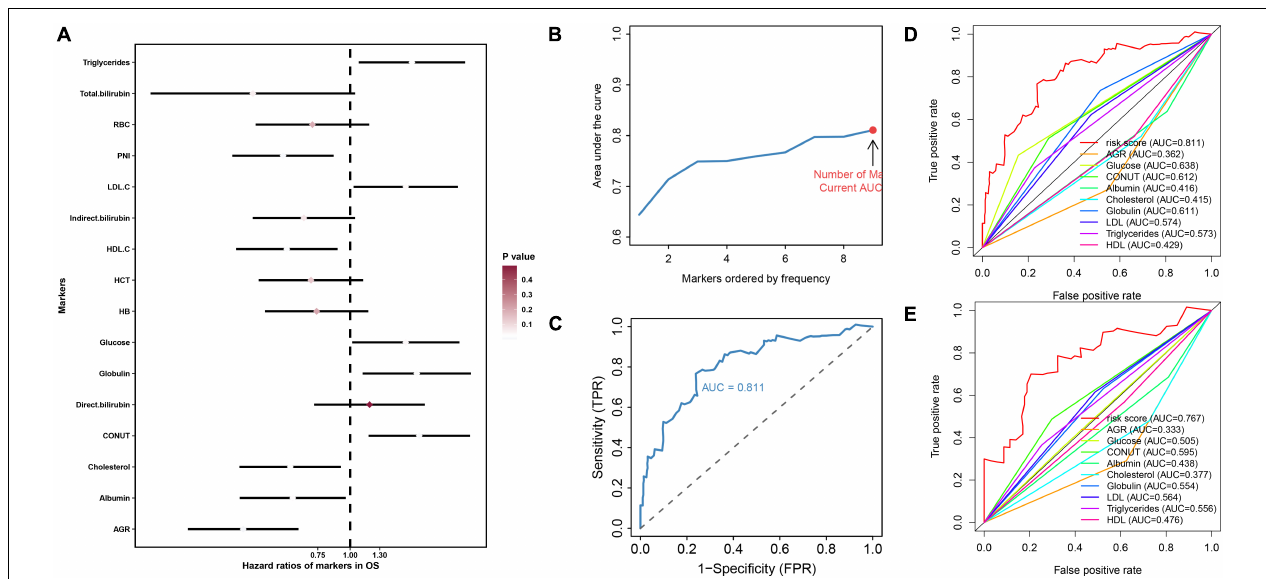
FIGURE 1 | The construction process of NMRS and the comparison between NMRS and individual hematological markers in terms of predictive ability. (A) Forest plot presented the results of univariate cox regression analysis of 16 hematological markers in the overall cohort. Where the smaller the p value, the closer the color of the diamond of the marker is to white; (B,C) With the continuous inclusion of the marker with high frequency retained in LASSO regression analysis into the model, the AUC value of the model continues to rise. When the 9th marker is included in the model, the AUC value of the model reaches the highest value, and this model is NMRS; (D) ROC curves of the predictive ability of NMRS and individual hematological markers in the training set; (E) ROC curves of the predictive ability of NMRS and individual hematological markers in the validation set.